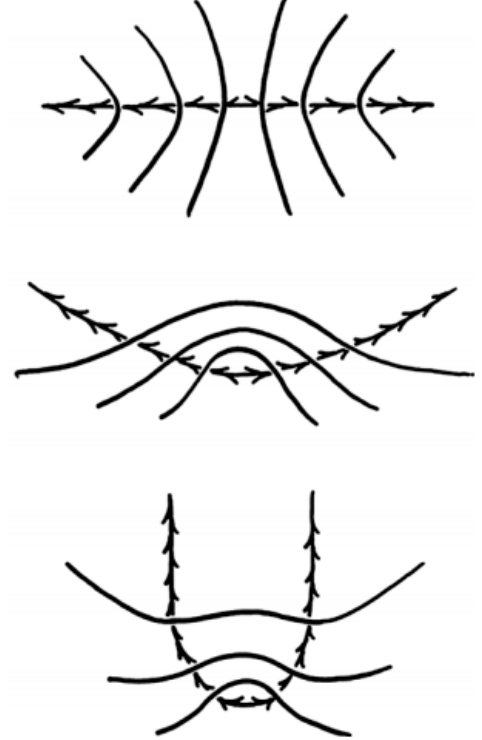
Figure 14. Gradients of tension experienced by the surrounding tissues. Linear compression at the point where the barbs change direction ( top ); Accurate placement imparts a mound by adding a vertical vector to the horizontal vector ( middle ) and U-shaped deployment results in the forces on the barbs being opposed by the bend in the U, rather than by the opposing barbs ( bottom ) [10,33]. Innovative barbed surgical sutures play an important role in “lunch-time” facelift procedures since patients prefer the least invasive or non-invasive surgeries. Facial rejuvenation for transforming facial aging has evolved from tension-based procedures such as mini facelifts to various subcutaneous, sub-SMAS and sub-periosteal planes of dissection. Atiyeh et al. investigated the efficacy of barbed sutures used for “lunch-time” facelift surgeries. The “lunch-time” facelift surgery is a procedure that avoids large incisions, signi fi cant undermining or substantial recovery time. The study was focused on the di ff erent variations of barbed sutures, namely short Aptos TM threads (Tbilisi, Georgia) for Aptos TM lift or Feather lift procedures, long Wo ffl es threads (Kolster Methods Inc., Corona, CA, USA) that were preferred for suspension of sagging tissues and Contour TM threads with unidirectional barbs and an anchor loop on one end, which are known as Feather lift ex- tended Aptos TM length threads, that were used in di ff erent facial rejuvenation surgeries in earlier days when barbed sutures were introduced as an alternative to conventional fi laments. It was mentioned that barbed sutures are used in facial aesthetic surgeries, which involve the lifting of brows, midface, lower face and neck. The minor complications that were reported due to the use of barbed sutures were mild facial asymmetry, swelling, erythema, hematoma, slight discomfort and scar formation at the entry and exit sites. When Contour TM threads were used for the facelift procedures, there were noticeable ec- chymosis and swelling, which persisted for many days, if not weeks. The study concluded that the use of barbed sutures could be an alternative tool for lifting ptosis tissues, but the preferred use is in open surgical procedures. The choice of barbed sutures requires careful evaluation and acceptance during open rather than laparoscopic procedures [38]. Kaminer et al. investigated the long-term e ffi cacy of barbed sutures for minimally invasive thread-lift procedures. They studied the e ffi cacy of Aptos TM threads and the mod- i fi ed Aptos TM threads (Isse Endo Progressive Face Lift Suture ® ) (Tbilisi, Georgia), which